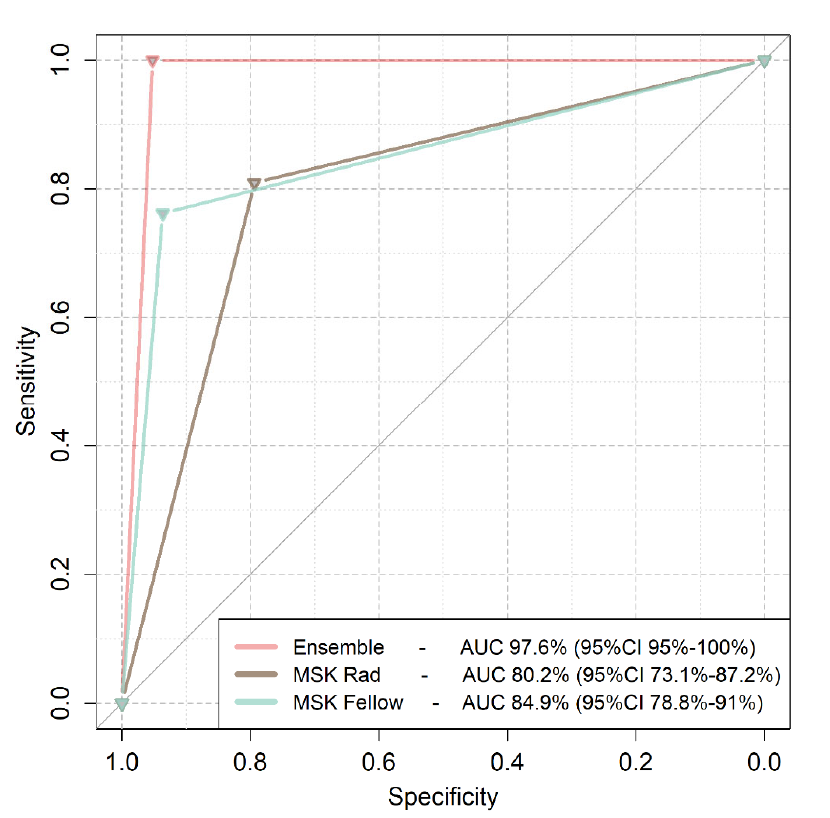
Figure 4. Receiver Operating Characteristics (ROC) curves of the model ensemble and MSK imaging experts. Model ensemble curve is plotted as a pink line, the MSK radiologist curve is plotted with brown color and the MSK fellow curve is plotted with a turquoise color. MSK Rad: Musculoskeletal Radiologist; AUC: Area Under the Curve.